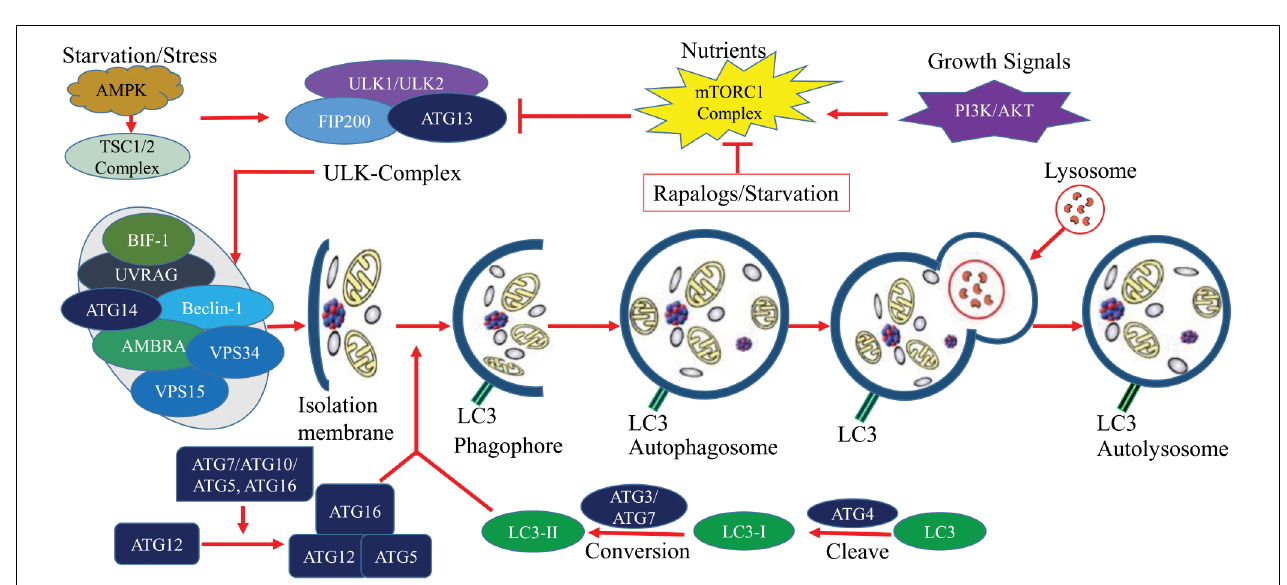
FIGURE 1 | Global cancer impact in (A) 2012 and (B) 2015. In 2012, the death toll 8.2 million from 14 million new cases. It raised gradually to 8.8 million in 2015. The growth of cancer death was more than 7% from 2012 to 2015. The most common cancers were Lung cancer, liver cancer, stomach cancer, colorectal cancer, esophageal cancer, and breast cancer was a major threat of women cancer death worldwide. These figures were based on data published by WHO and GLOBOCAN (Ferlay et al., 2015; GBD 2015 Risk Factors Collaborators, 2016; WHO, 2018).